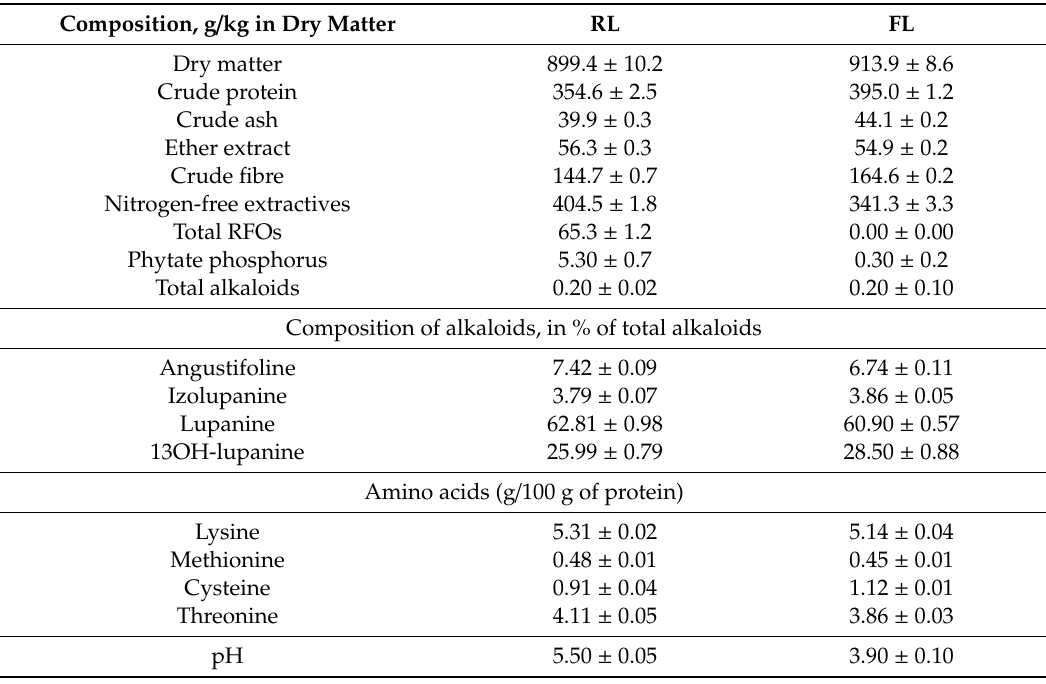
Table 2. The chemical composition of raw and fermented lupine